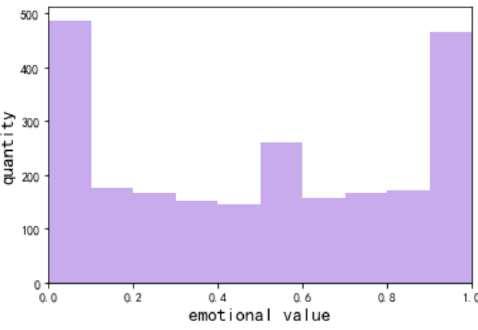
Figure 4. The overall emotional distribution of users.